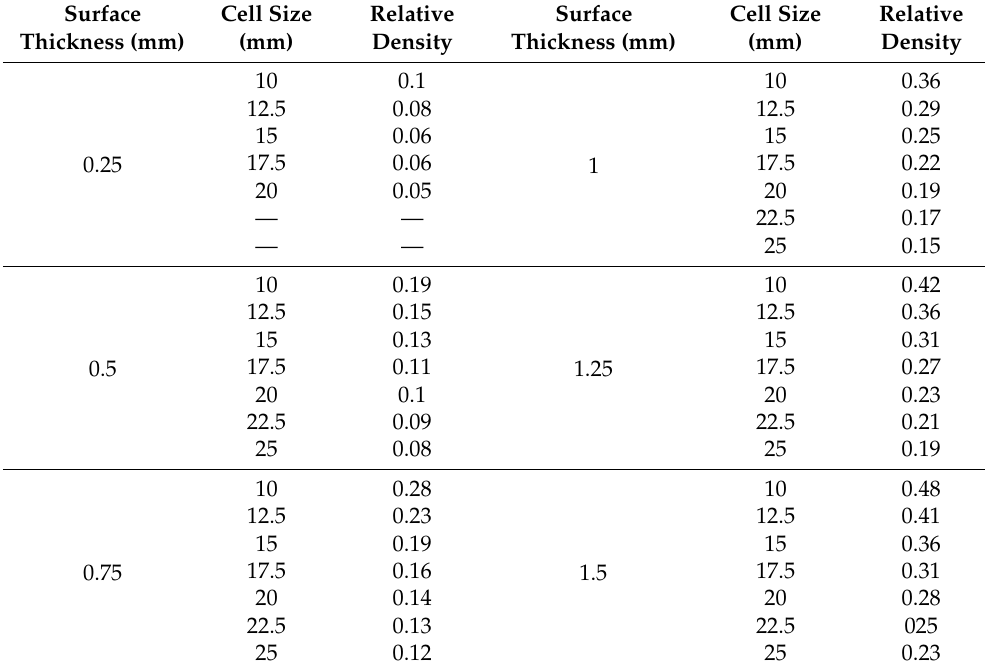
Table 3. Structure parameters of the D